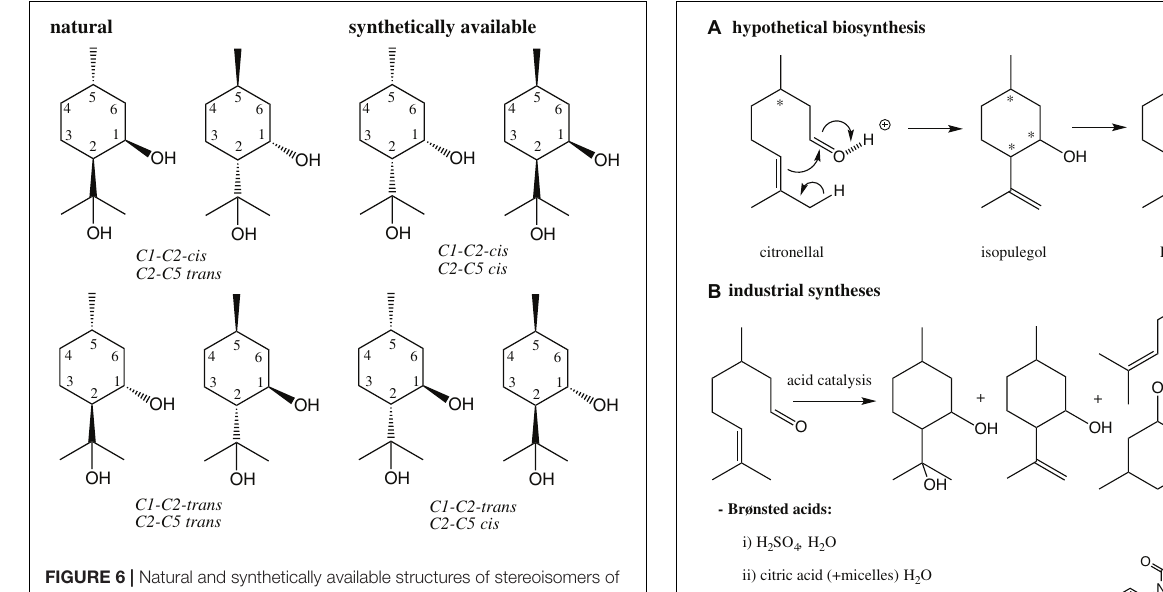
cannot meet market demand. That is why the majority of the PMD used in repellents is derived from synthetic processes.